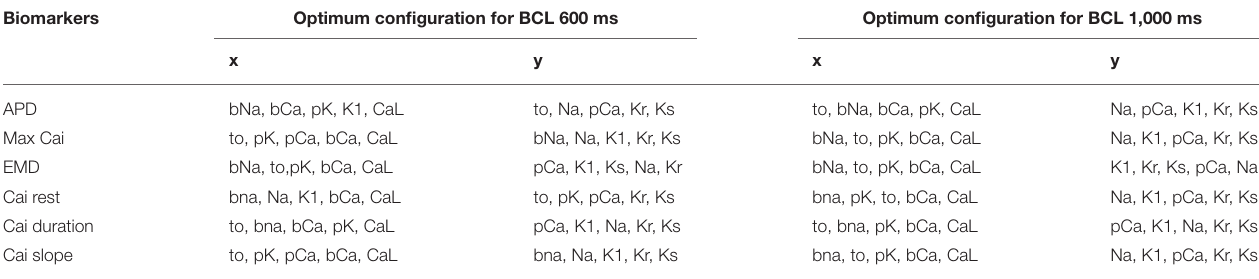
TABLE 1 | The list of axis configuration for the optimum map.